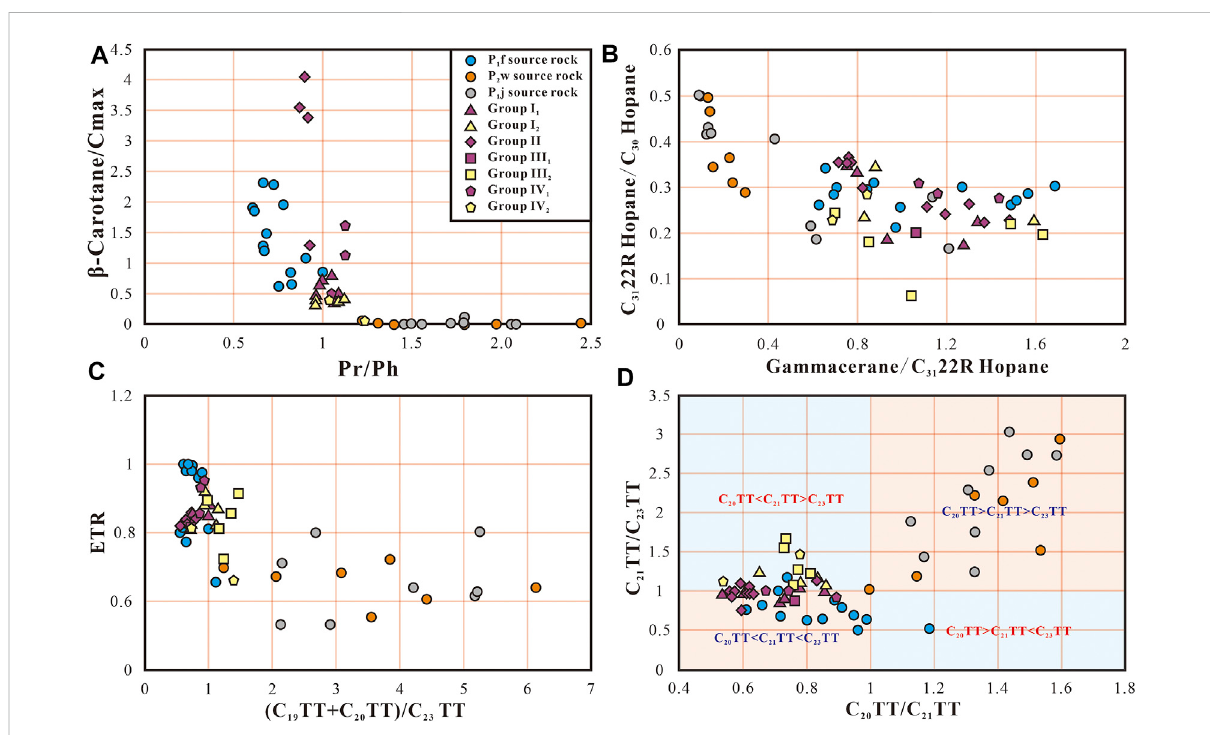
FIGURE 11 Cross-plotsofbiomarkerparametersfromthestudiedCarboniferouscrudeoilsamplesandP 2 w,P 1 f,andP 1 jsourcerocksamples. (A) PlotofPr/ Ph versus β -Carotane/Cmax; (B) Plot of gammacerane/C 31 22R homohopane versus C 31 22R homohopane/C 30 hopane; (C) Plot of (C 19 TT + C 20 TT)/ C 23 TT versus ETR; (D) Plot of C 20 TT/C 21 TT versus C 21 TT/C 23 TT.